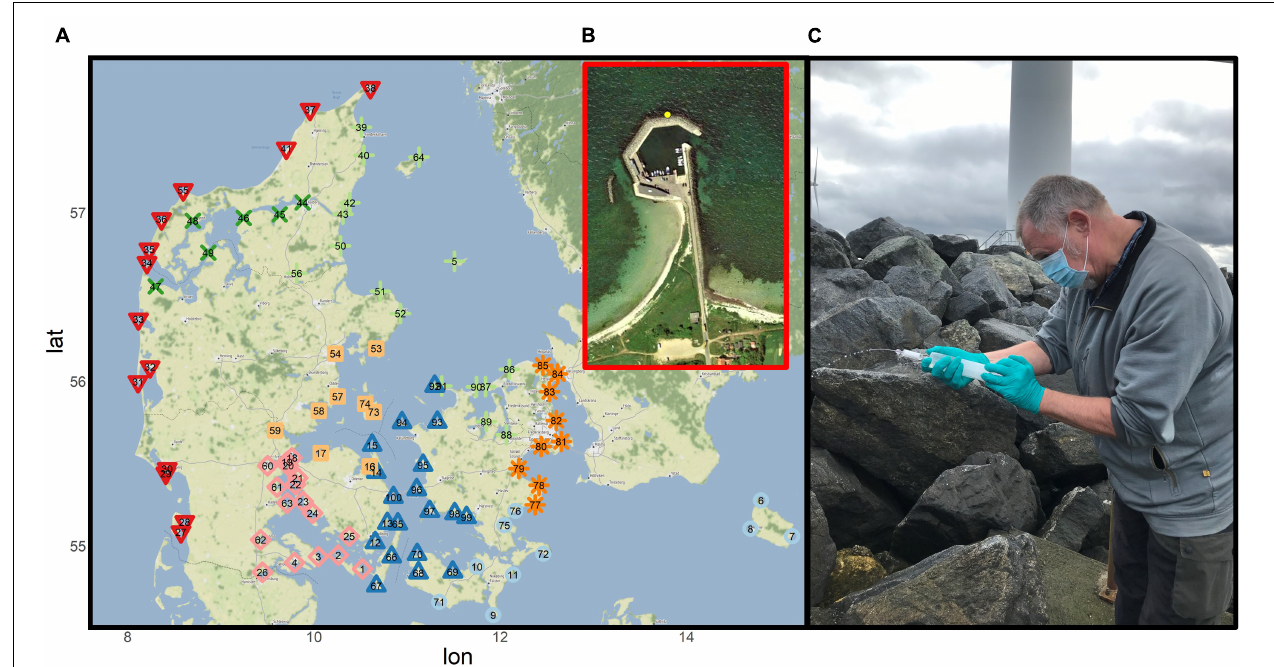
FIGURE 1 | (A) Map of sampling sites in Denmark showing the 100 locations, which were sampled by citizen scientist on the 29th of September 2019 and again on the 10th of May 2020. Locations are divided into eight sub-areas based on marine regions, North Sea (red, triangle-down), Limfjord (dark green, cross), Kattegat (light green, plus), Samso Belt (light orange, squares), Great Belt (dark blue triangle-up), Little Belt (pink, diamond), Baltic Sea (light blue, circle), and The Sound (dark orange, asterix). (B) Røsnaes Harbour (number 94 on the map) representing a typical sampling site. (C) The citizen scientist Niels-Ole Hørlyk filtering water through the filter at Bønnerup Harbour (number 51 on the map) on the 29th of September 2020 (Photograph by: Niels-Ole